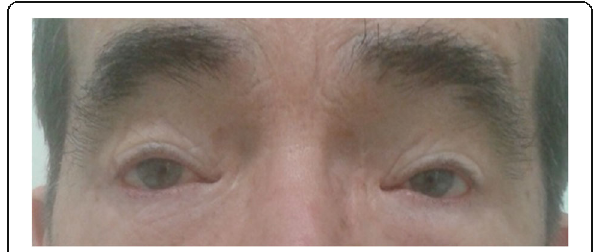
Fig. 2 Ophthalmological phenotype of patient ’ s father (I:1)